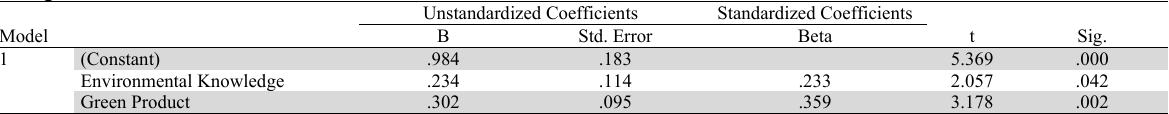
Multiple Regression Analysis between managers’ environmental knowledge and green product awareness as DV and Green management as ID